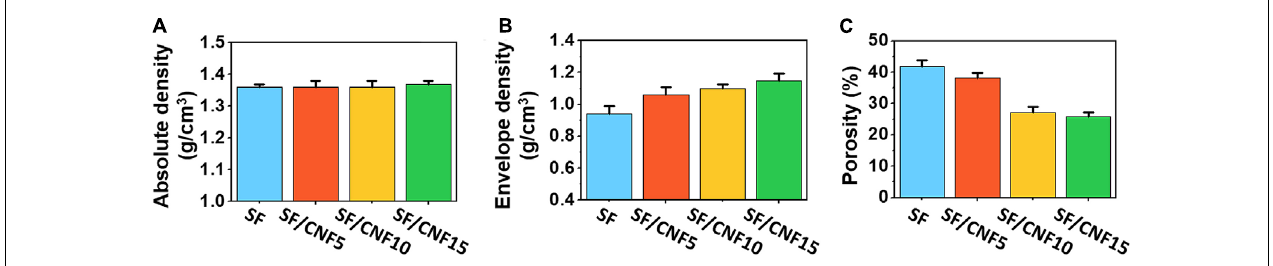
FIGURE 3 | Absolute density (A) , envelope density (B) , and calculated porosity (C) of the SF/CNF composites with various amounts of CNFs.